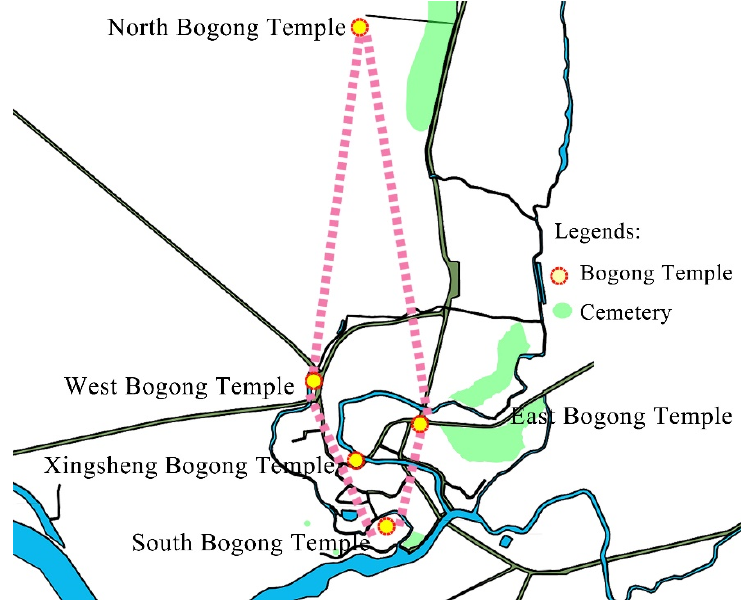
Figure 4. Location of Bogong in the East, West, South, North and Centre of the Wugoushui Settlement.